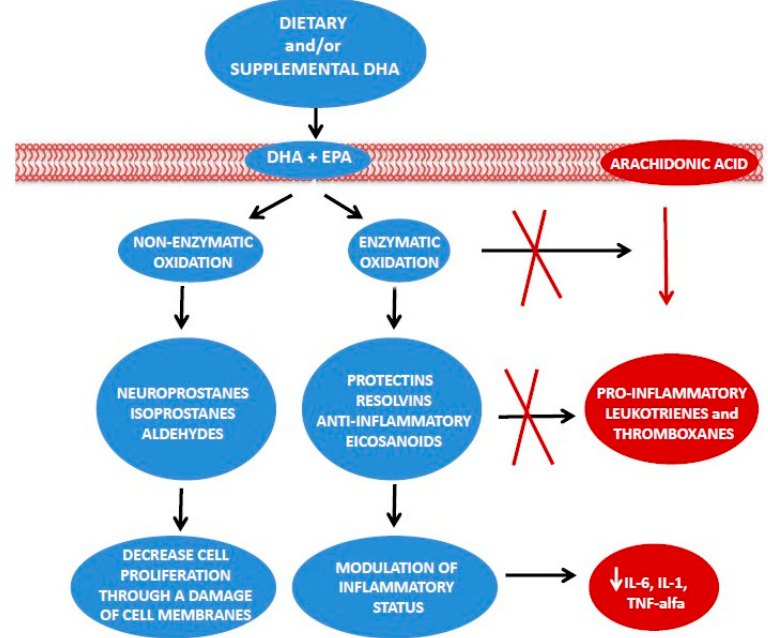
Figure 1. Enzymatic way and non-enzymatic way for ω -3 PUFAs. DHA, docosahexaenoic acid; EPA, eicosapentaenoic acid; IL-6, interleukin-6; IL-1, interleukin-1; TNF-alfa, tumour necrosis factor- α .